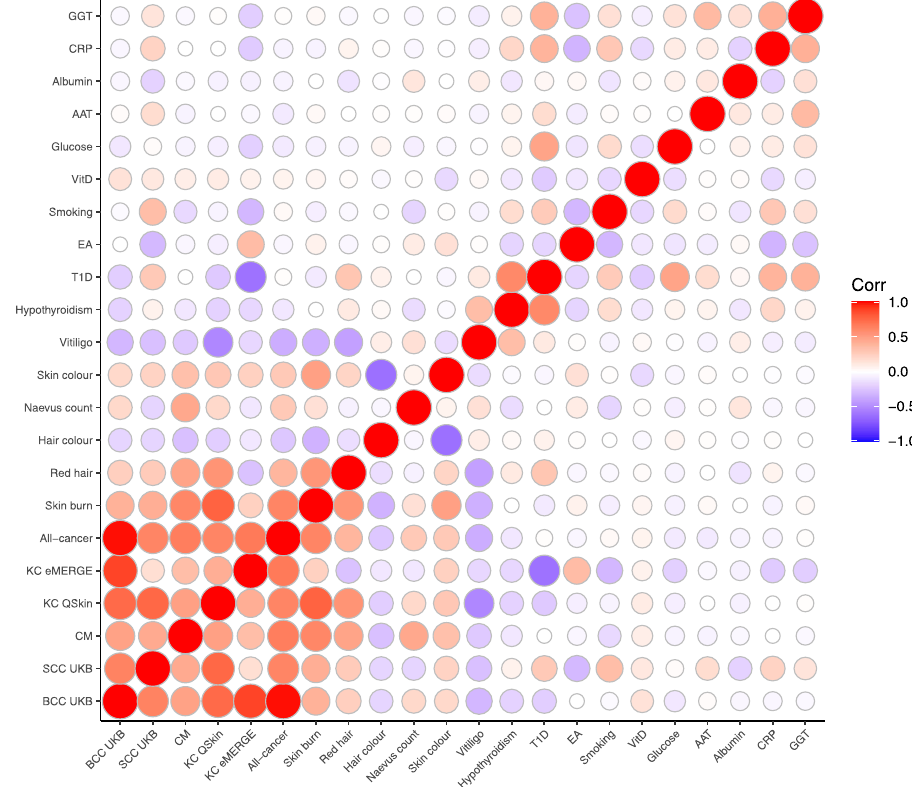
Fig. 1|Heatmapforthegeneticcorrelation between22traitswithasigni fi cant correlation with either BCC or SCC. Bivariate genetic correlation 22 traits that were signi fi cantly correlated ( P <0.05, rg >10%) with the UKB BCC or SCC GWAS. BCC UKB basal cell carcinoma in the UK Biobank, SCC UKB squamous cell carci- noma in the UK Biobank, CM cutaneous melanoma, KC QSkin keratinocyte cancer